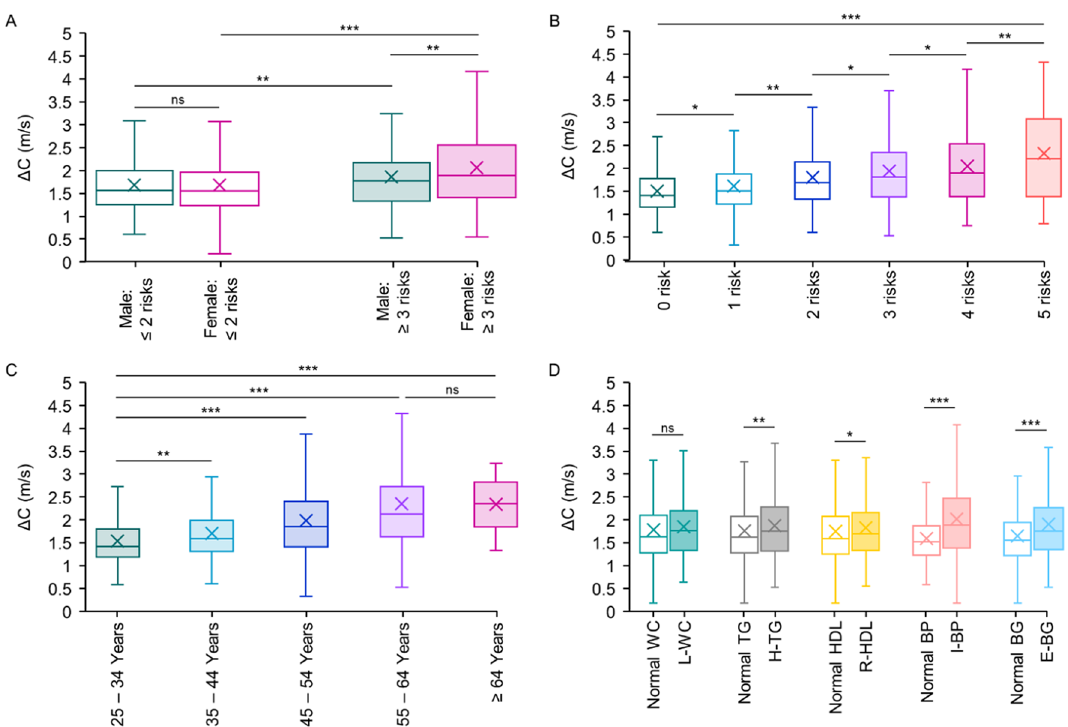
Figure 2. Incremental pulse wave velocity, ΔC, of ( A ) male versus female subjects for Non-MetS and MetS groups, ( B ) Non-MetS and MetS groups with multiple risk factors, ( C ) subjects based on their chronologic age, ( D ) subjects with/without the presence of individual metabolic abnormality (ns p > 0.05, * p ≤ 0.05, ** p ≤ 0.001, *** p ≤